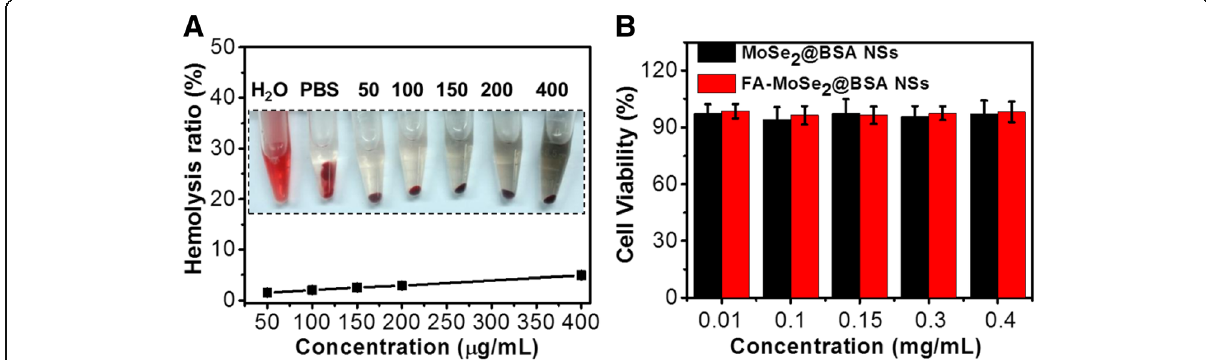
Fig. 4 a Hemolysis ratio of RBCs after 1-h incubation with FA-MoSe 2 @BSA NSs at different concentrations. The inset shows the photograph of RBCs exposed to distilled water, PBS, and FA-MoSe 2 @BSA NSs with different concentrations followed by centrifugation. b Cell viability of 4T1 cells after treatment with towards MoSe 2 @BSA NSs and FA-MoSe 2 @BSA NSs at different concentrations for 24